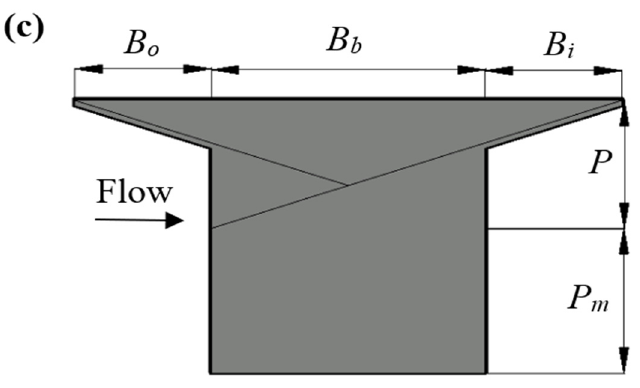
Figure 2. ( a ) Top view of PK weir type A model, ( b ) Side view of PK weir at Section 1, ( c ) Side view of PK weir at Section 2 [20].